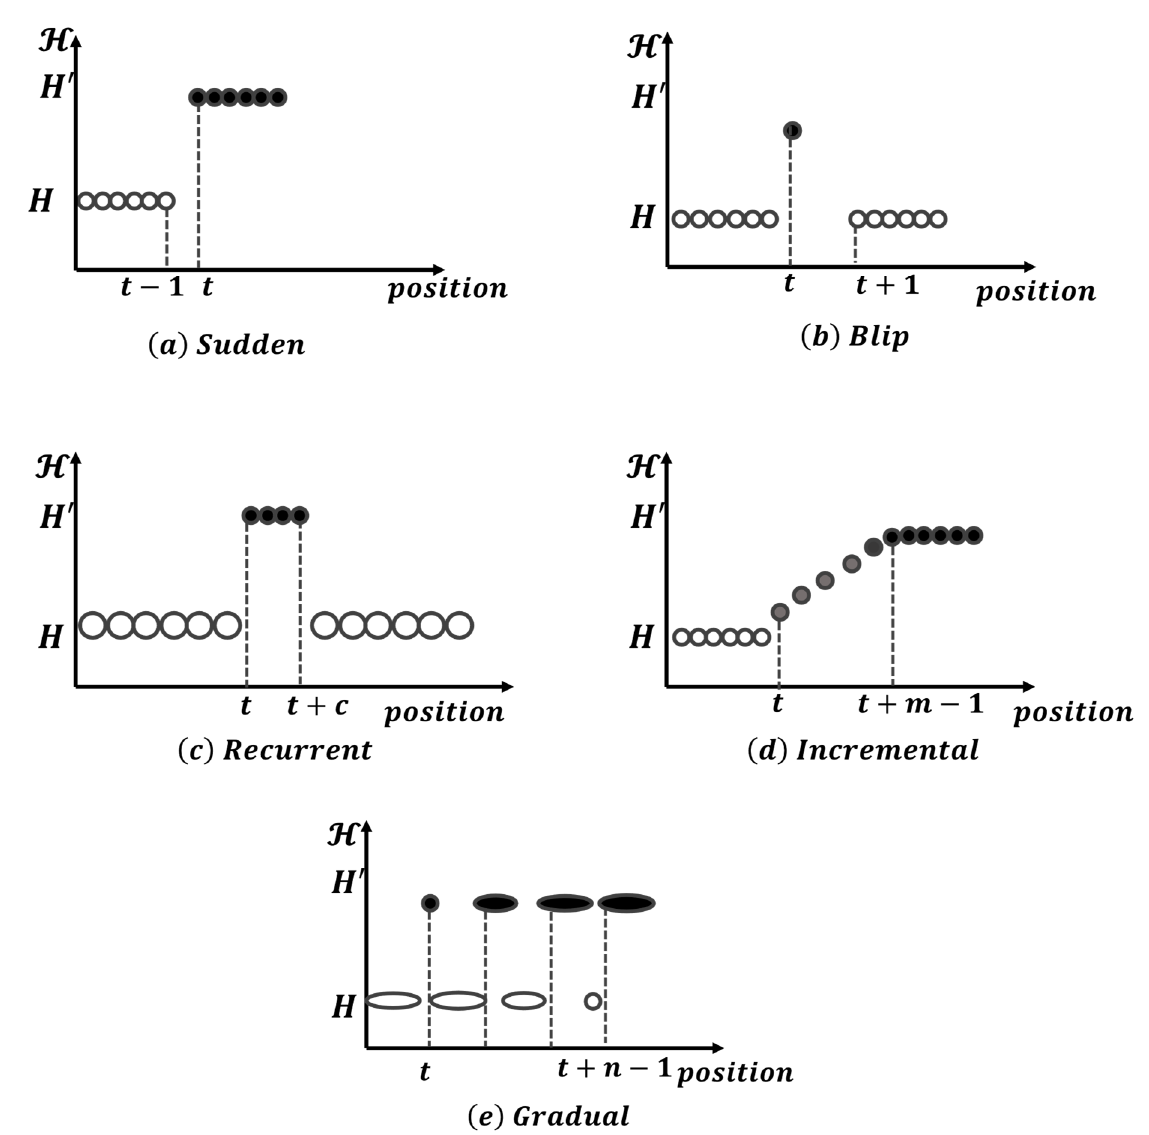
Figure 1. Conceptual diagram of the main variants of concept drift: ( a ) sudden, ( b ) blip, ( c ) recurrent, ( d ) incremental, and ( e ) gradual [19].